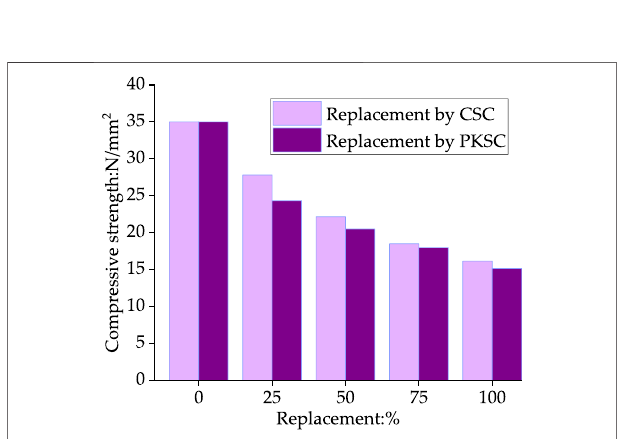
FIGURE9| ComparisoncompressivestrengthofCSCandPKSCofmix proportion 1:1:2 at 28 days curing (Olanipekim et al., 2006).